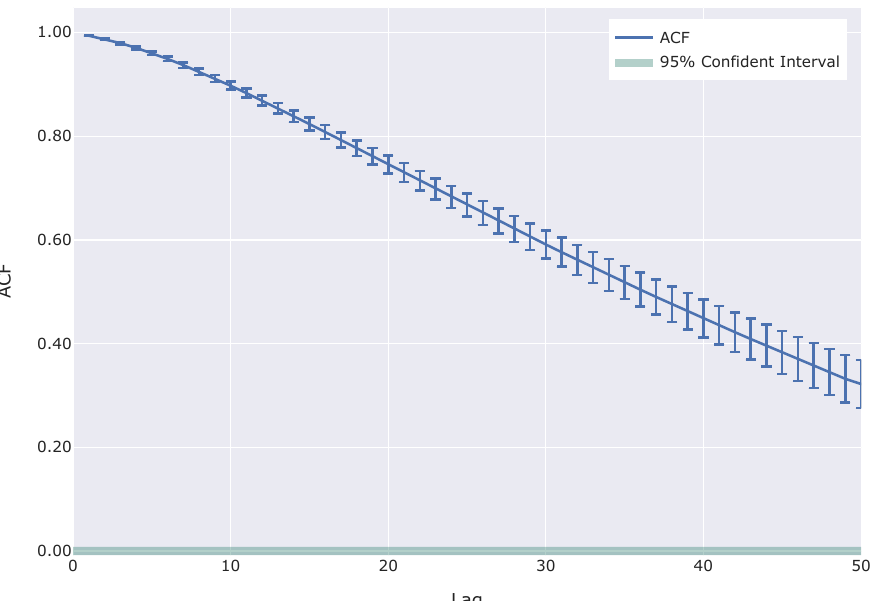
Figure 4. Autocorrelation function (ACF) for 50-step standard deviations of logarithm returns. Error bars mean standard deviation for each lag among 500 markets in 100 simulations. The green area shows the 95% confident interval corresponding to each lag.